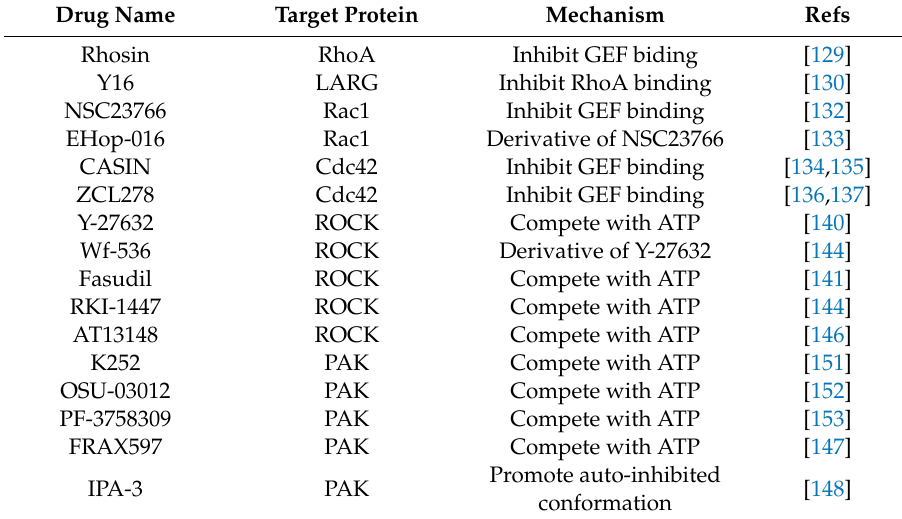
Table 2. Selected inhibitors of Rho GTPase